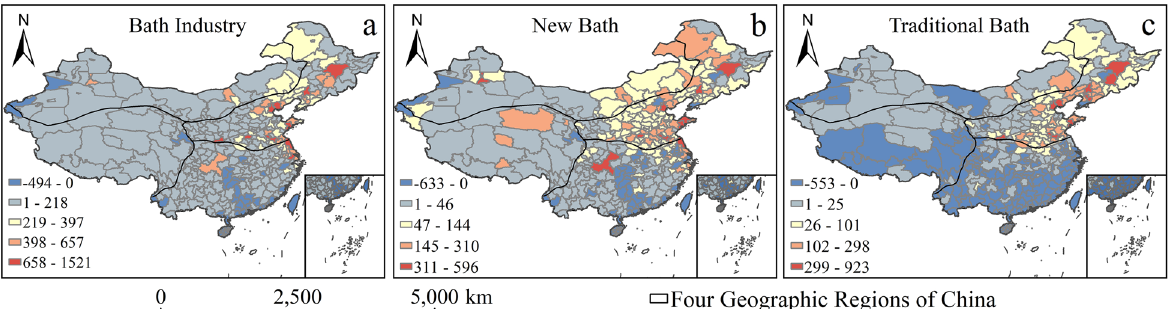
Fig. 3 Bath industry and its sub-categories growth chart